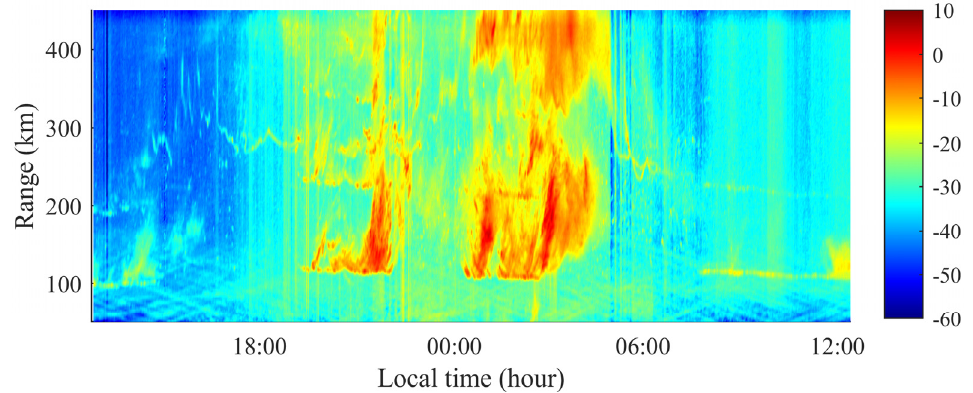
Figure 3. The RTI plot of radar returns: the radar was operated at 4.7 MHz between 24 August 2021 and 25 August 2021.